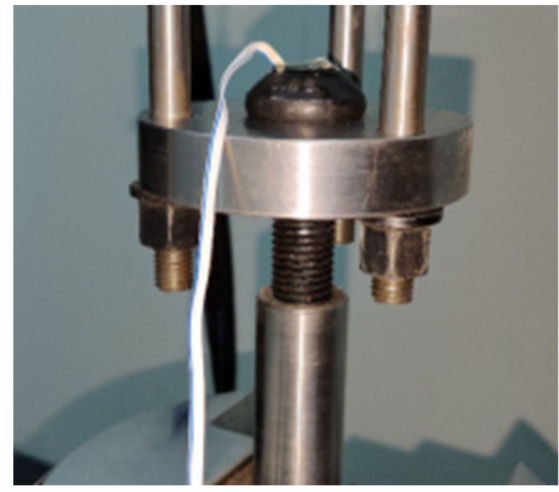
Figure 4. Calibration of high-strength bolts.